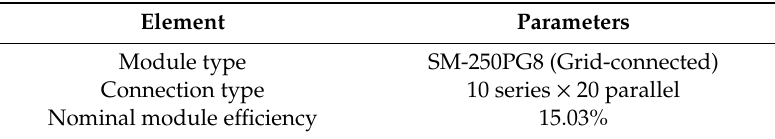
Figure 2. The BIPV generation system installed on a medium-sized office building. Table 1. Specifications of the BIPV generation system.